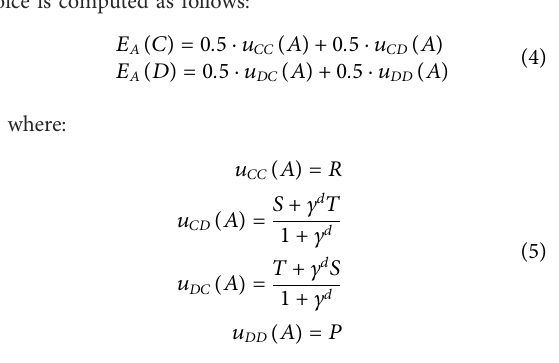
TABLE 3 Payoff Matrix for 3-player collusion game. Payoffs are in the order ( π A , π B , π C